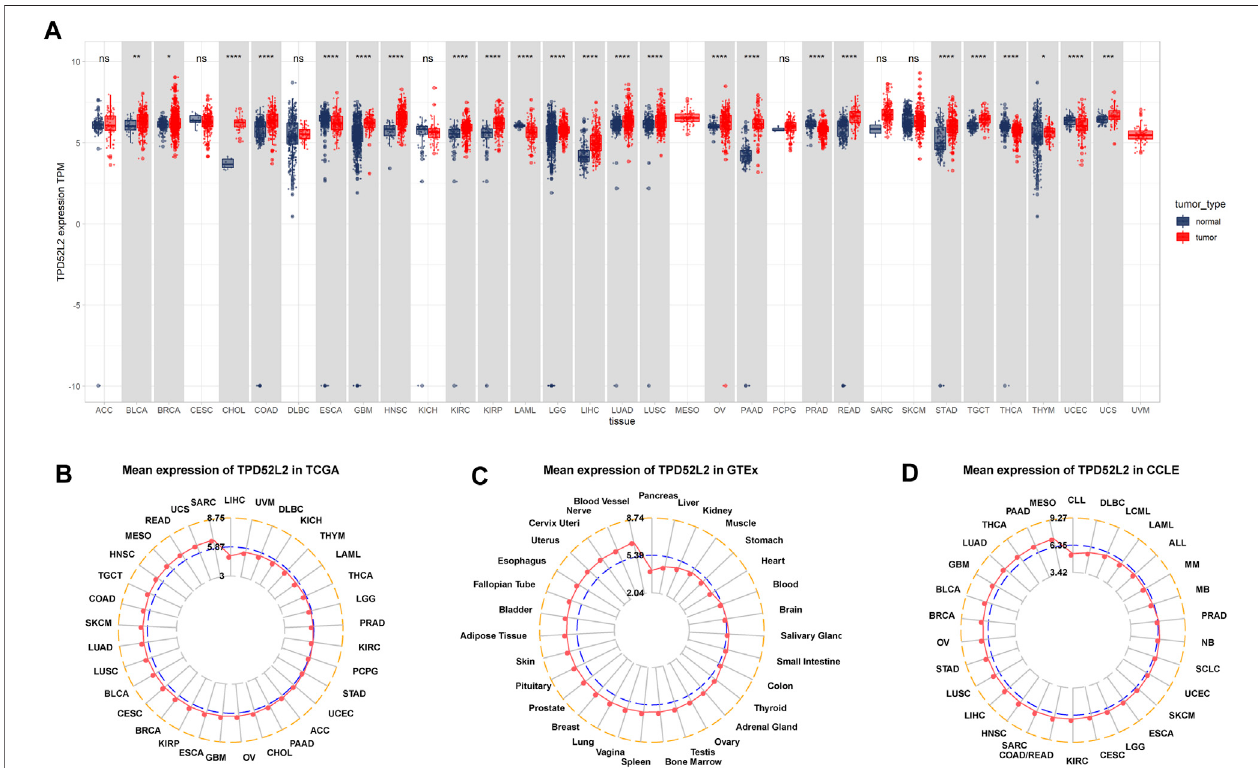
FIGURE 1 | Expression of TPD52L2. (A) Pan-cancer expression of TPD52L2. (B) TPD52L2 expression in tumor tissues from TCGA cohort. (C) TPD52L2 expression in normal tissues from the GTEx cohort. (D) TPD52L2 expression in cancer cell lines from the CCLE cohort. * p < 0.05, ** p < 0.01, *** p < 0.001, and **** p <